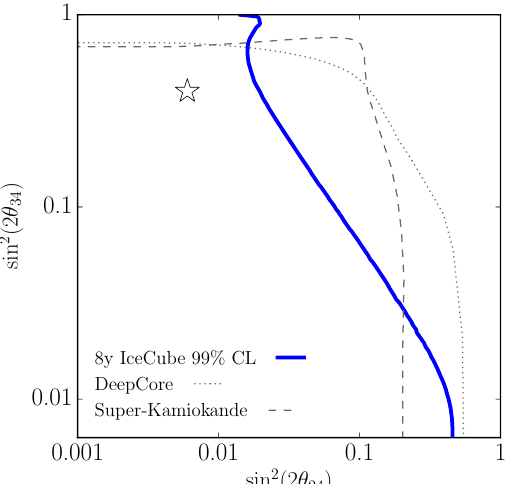
Figure 4. In blue solid: 99% C.L. exclusion in the regime of fast oscillations, i.e., heavy sterile neutrinos. The star shows the best fit, and results from other experiments are also shown